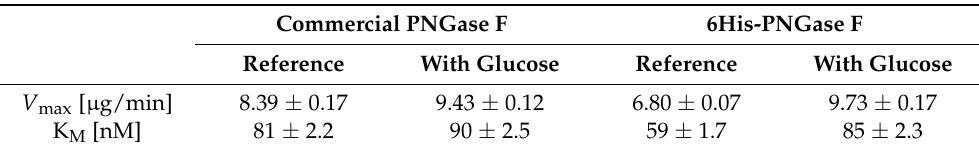
Table 1. Maximum reaction rates ( V max) and Michaelis ‐ Menten constants (K M ) based on the results in Figures 3 and 4 for the in ‐ house produced 6His ‐ PNGase F and the commercial PNGase F en ‐ zymes, respectively. The “reference” columns represent the values without 1 mg/mL glucose in the reaction mixture.